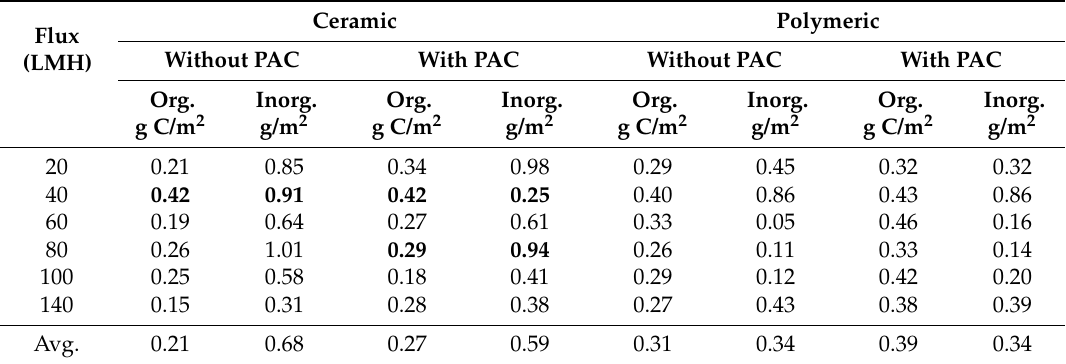
Table 6. Organic and inorganic foulant recoveries (in g/m 2 ) from CIP